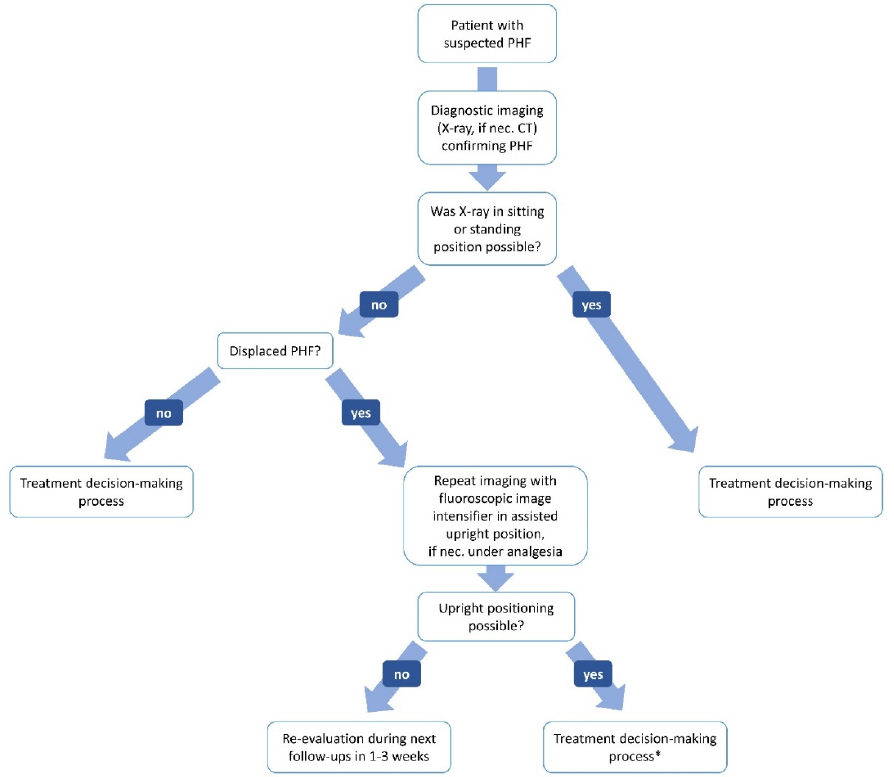
Figure 1. Patients’ journey in the form of an algorithm. * Further self-reducing potential should be taken into account.